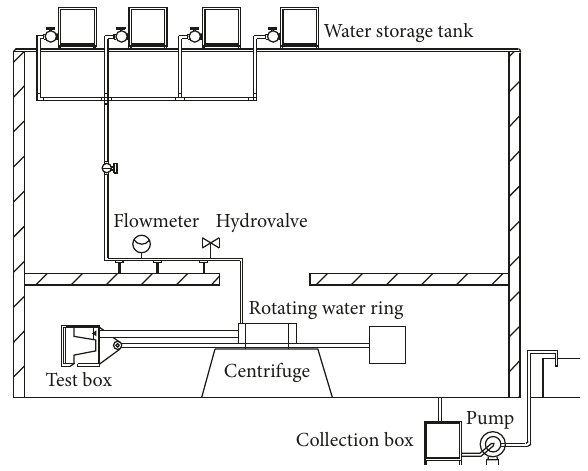
Figure 1: The centrifugal model test equipment for dam